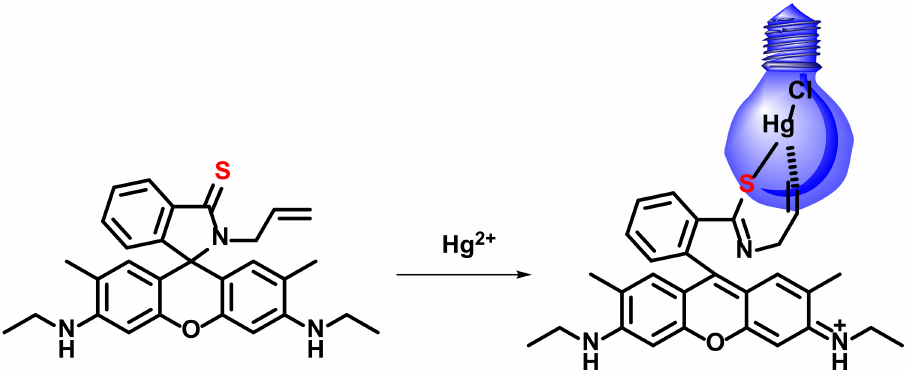
Figure 9. Fluorescent chemosensor with S and alkene moiety showing turn-on response upon addition of Hg 2+ ion. Reproduced with permission from [25] by Royal Society of Chemistry.